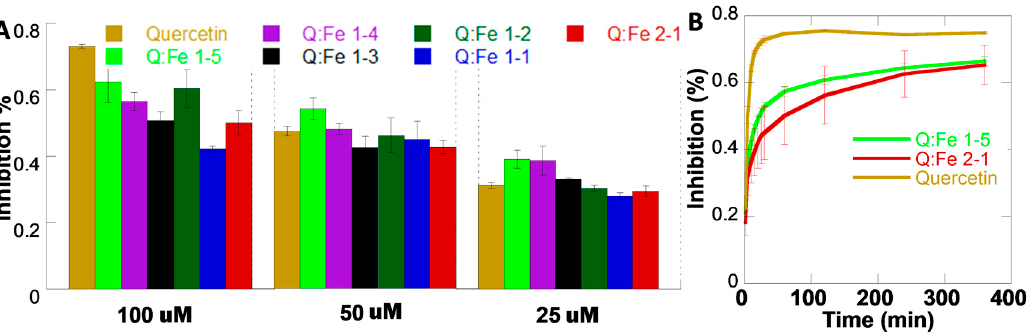
Figure 6. DPPH assay: ( A ) inhibition (%) of DPPH by free Q and QFeNPs with various Q-Fe ratios after 40 min at 100 µM, 50 µM, and 25 µM; and ( B ) time-dependent inhibition (%) of DPPH by free Q and QFeNPs with Q-Fe ratios of 2:1 and 1:5 at 100